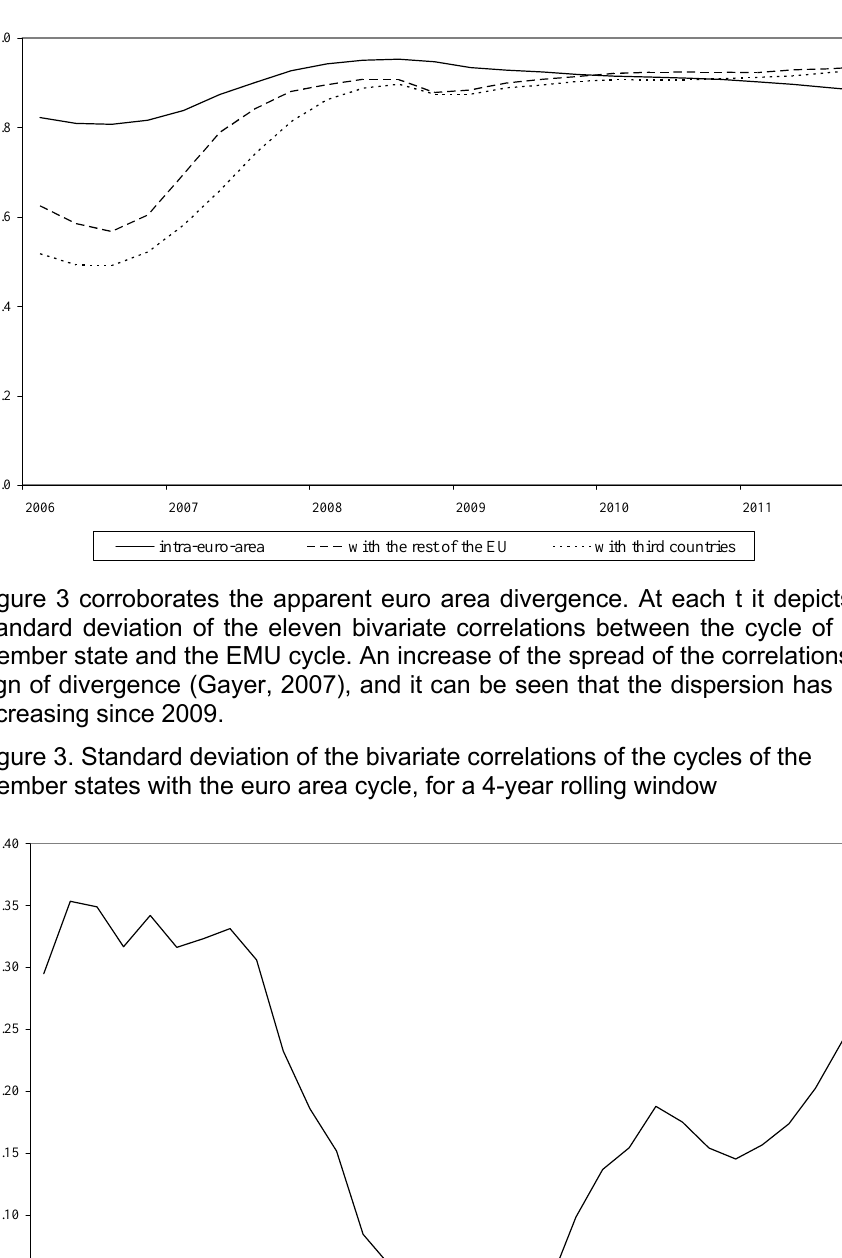
Figure 2. Mean cyclical correlations with the euro area for a 6-year rolling window